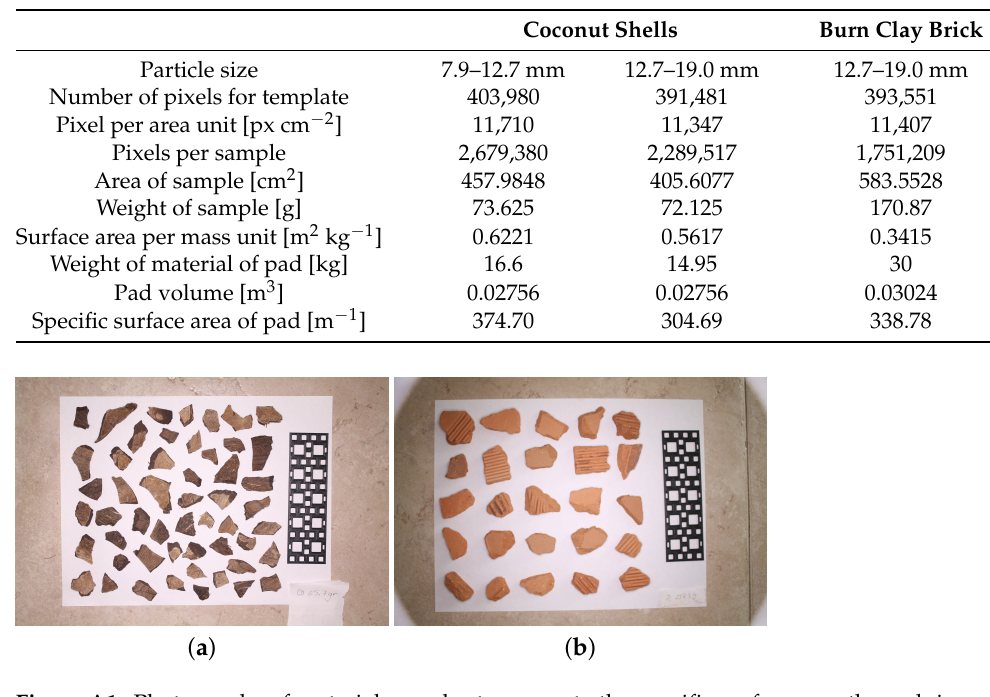
Figure A1. Photographs of material samples to compute the specific surface area through image processing. ( a ) Particles of coconut shells. ( b ) Particles of burn clay bricks.